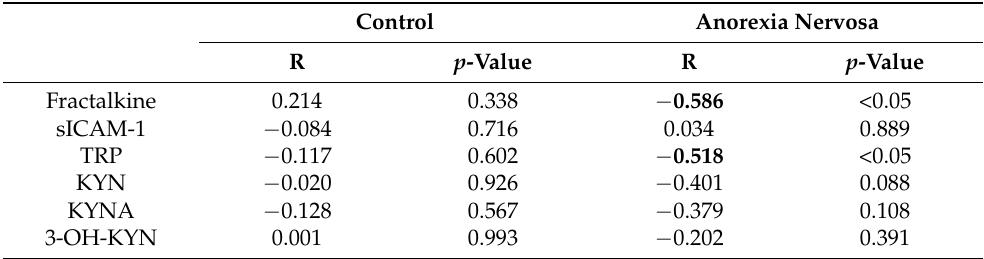
Table 4. Correlations of fractalkine, sICAM-1 and TRP metabolites with BMI in anorexia nervosa.